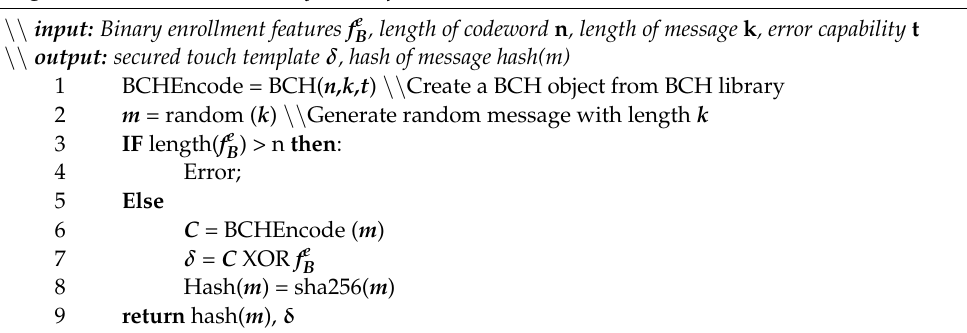
Algorithm 4 Commit the binary_enroll_feature of the user.